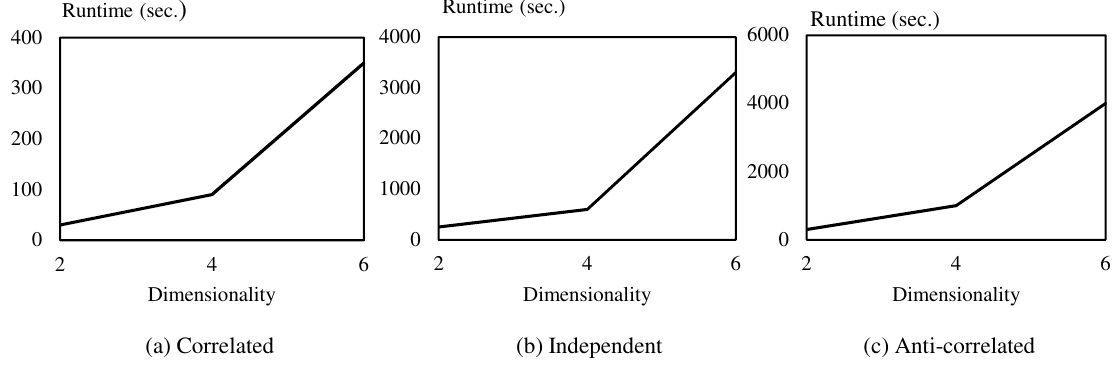
Figure 8. Performances with different data